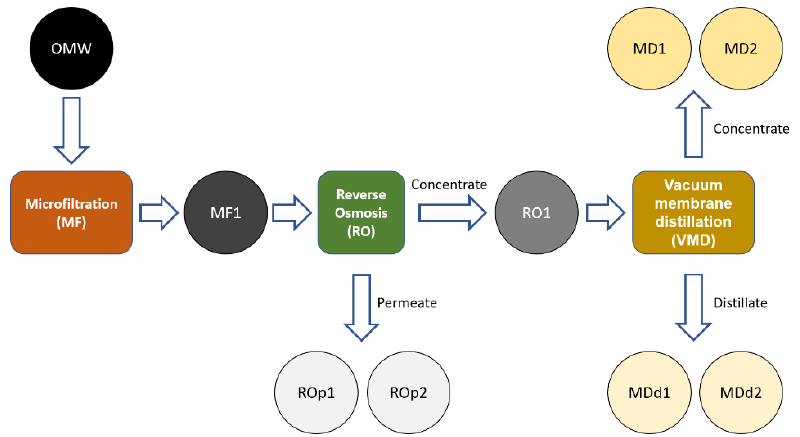
Figure 2. Schematic representation of OMW purification process. Analyzed samples: MF1: sample collected after the MF. ROp1: permeate sample collected in the middle of RO purification. ROp2: final permeate sample of RO purification. MD1: initial concentrate sample of VMD. MD2: final concentrate sample of VMD. MDd1: initial distillate sample of VMD. MDd2: final distillate sample of VMD.